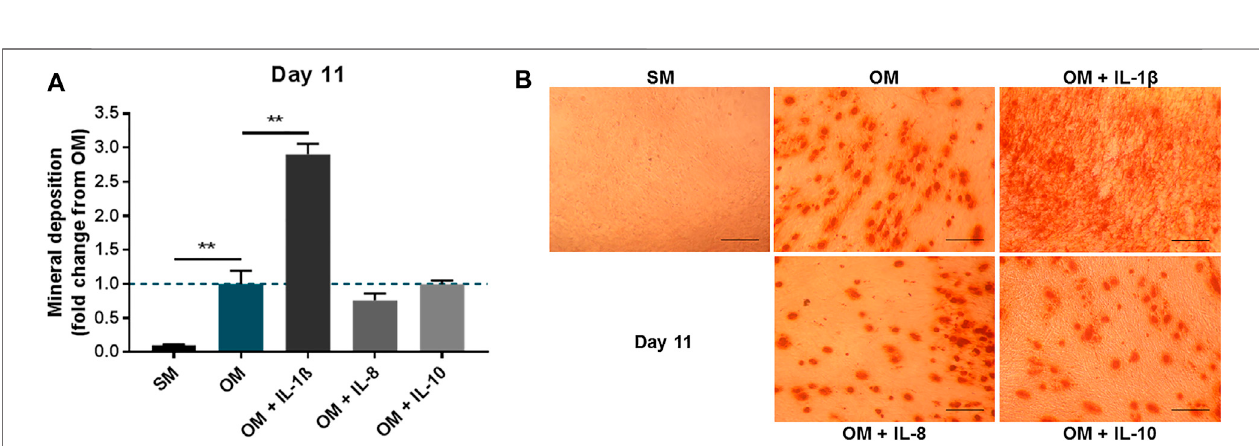
FIGURE4| Effects ofIL-1 β , IL-8or IL-10 supplementationon primary MSC cultures treated inosteogenic medium. (A) Mineral deposition incultures treatedin the presenceorabsenceofIL-1 β (100 pg/ml),IL-8(2 ng/ml)orIL-10(100 pg/ml)measuredafter11days. (B) RepresentativeimagesofAlizarinRedstainingatday11.Scale bar = 150 μ m. Data shown as fold change compared to the OM control condition. Error bars represent SEM. n = 3, ** p < 0.01.